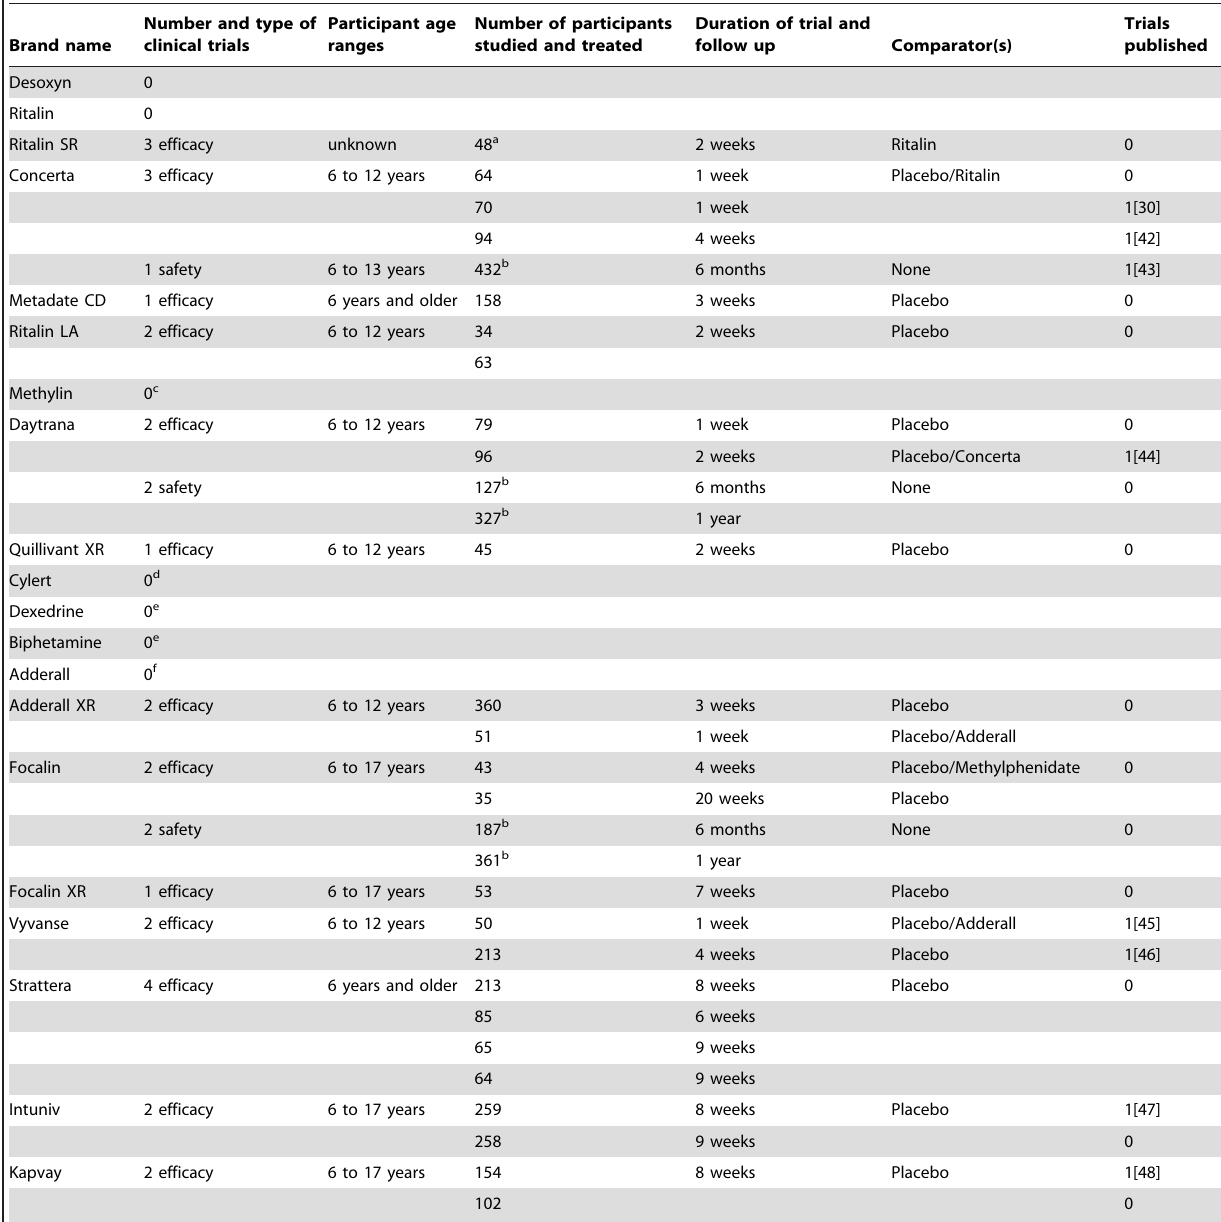
Table 2. Clinical trials conducted for the FDA approval of ADHD drugs in